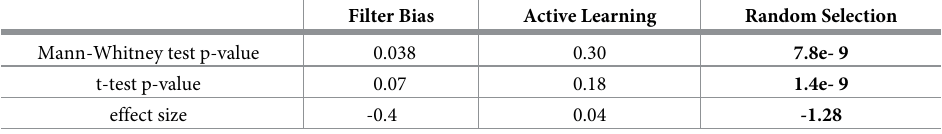
Table 9. Results of the Mann-Whitney U test and the t-test comparing boundary shift for the three forms of iter- ated algorithmic bias with class-dependent human action probability ratio 1:1 and 10:1. The effect size is calculated as ( Boundary | | )/ standard . dev at time t = 200. Both Filter bias and active learning bias ratio = 1: 1 − Boundary ratio = 10: 1 show no significant difference between the two ratios. On the other hand, random selection leads to more points pre- dicted to be in class y = 1.